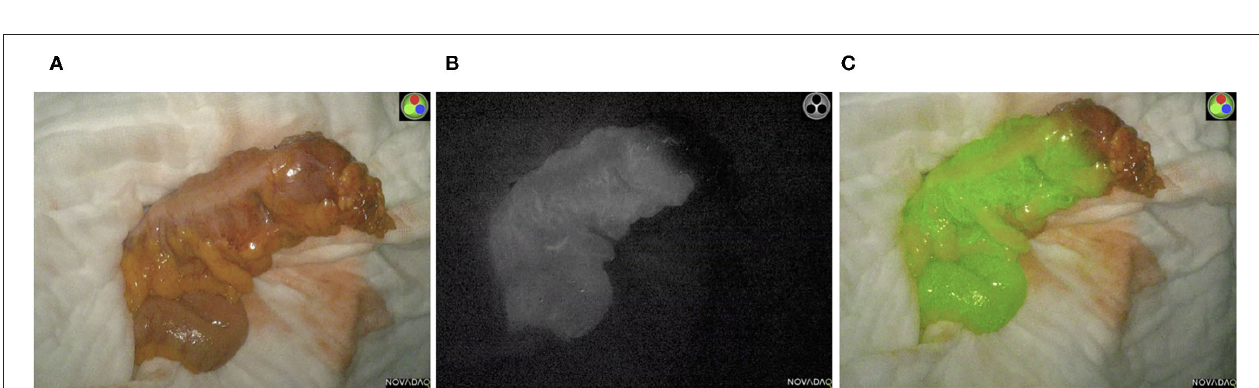
FIGURE 2 | Intraoperative ICG-NIFA showing an inadequate perfused descended colon after dissection requiring re-resection. (A) View with standard light. (B) View with NIR light. (C) View with the fluorescence mode of the PINPOINT endoscope Fluorescence Imaging System.